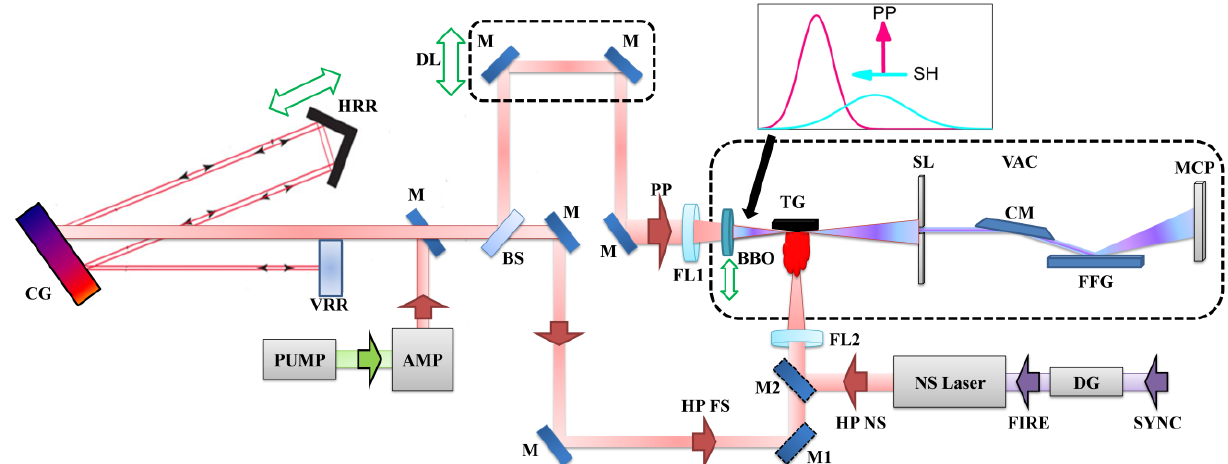
Figure 1. The experimental scheme of HHG. The uncompressed laser pulse after amplifier (AMP) is directed by a mirror (M) to the compressor comprising the compressing grating (CG), vertical retroreflector (VRR), and horizontal retroreflector (HRR). The compressed probing pulse (PP) propagates through the optical delay line (DL) and then focuses through a spherical focusing lens (FL1) inside the vacuum chamber (VAC) comprising the target chamber and XUV spectrometer. The focused pulses propagate through the 0.2 mm thick barium borate (BBO) crystal to generate a second harmonic (SH) beam for the two-color pump of plasma. Inset shows the relative positions of the SH (blue curve) and PP (red curve) and their polarizations after propagation of BBO. The femtosecond heating pulses (HP FS) are focused by a focusing lens (FL2) on the target (TG) to ignite the laser plasma. Optionally, nanosecond heating pulses (HP NS) are used. The delay between PP and HP NS is controlled by a digital delay generator (DG) triggered by a synchropulses (SYNC). The generated harmonics and fundamental radiation propagate through the slit (SL) and enter the XUV spectrometer comprising the cylindrical mirror (CM), flat-field grating (FFG), and micro-channel plate (MCP). M1 and M2 are the mirrors on flipping mounts for selecting either HP FS or HP NS.